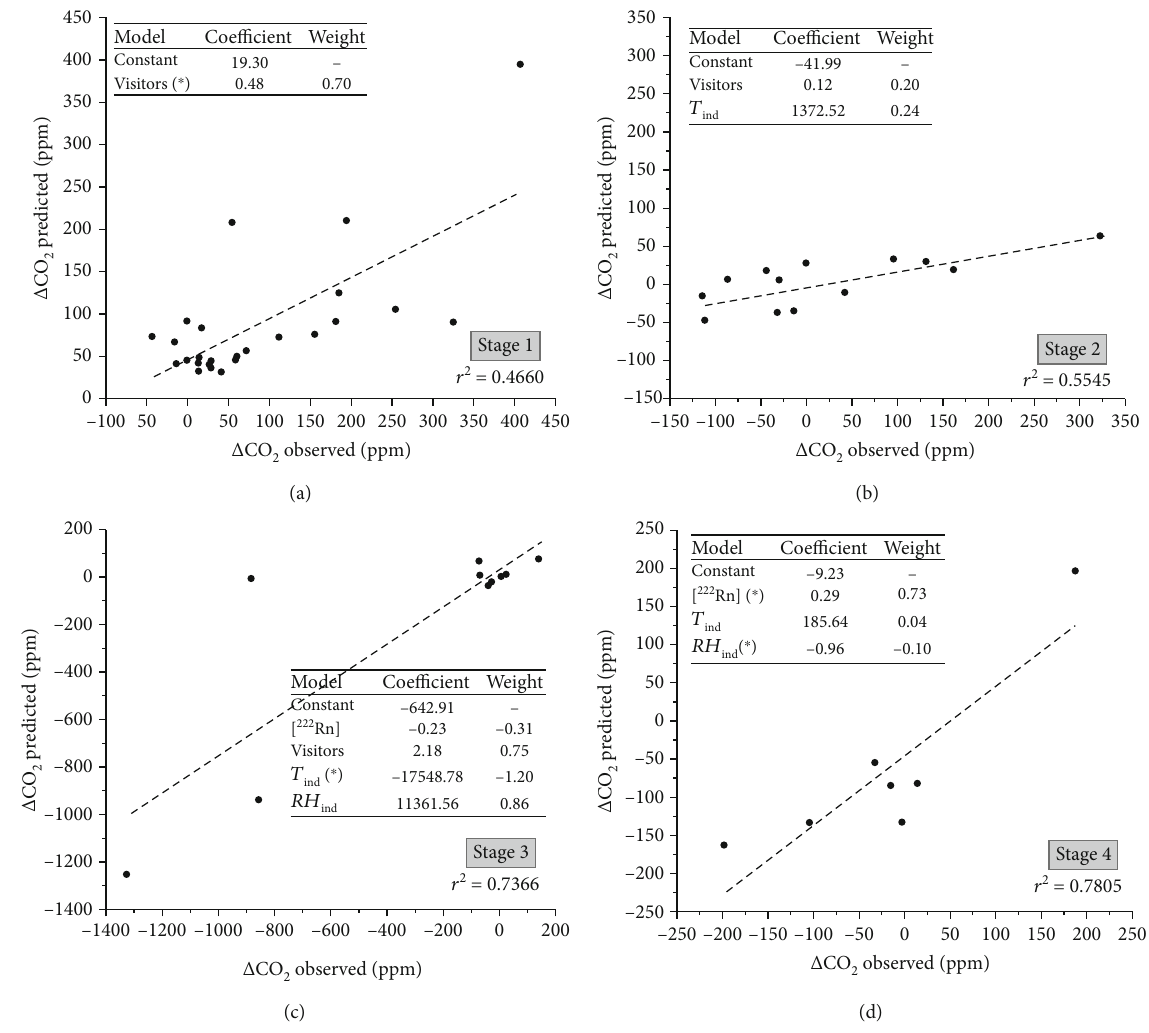
Figure 6: Observed and predicted values of CO increments considered for the di ff erent cave stages: (a) stage 1 (gaseous recharge), (b) stage 2 2 (maximum gas concentration in the cave), (c) stage 3 (gaseous discharge), and (d) stage 4 (minimum gas concentration in the cave). Predicted values are obtained in each case considering the predictor variables established in the PCA (Table 1). The unstandardized coe ffi cient (coe ffi cient) of each predictor variable within the multivariate analysis as well as its weight (standardized coe ffi cient) is shown for each individual prediction. ∗ indicates signi fi cant variables in the multivariate